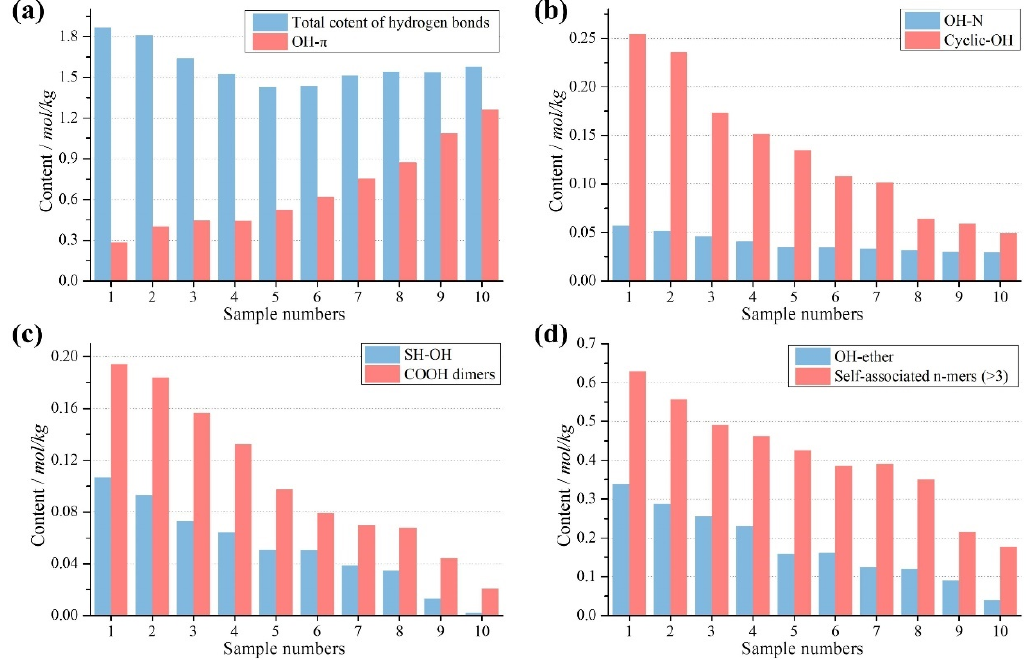
Figure 5. Content of HBs. ( a ) Content of SH–OH and COOH dimmers, ( b ) content of OH–N and cyclic OH, ( c ) content of OH–ether and self-associated OH, ( d ) content of OH– π and total content of HBs.